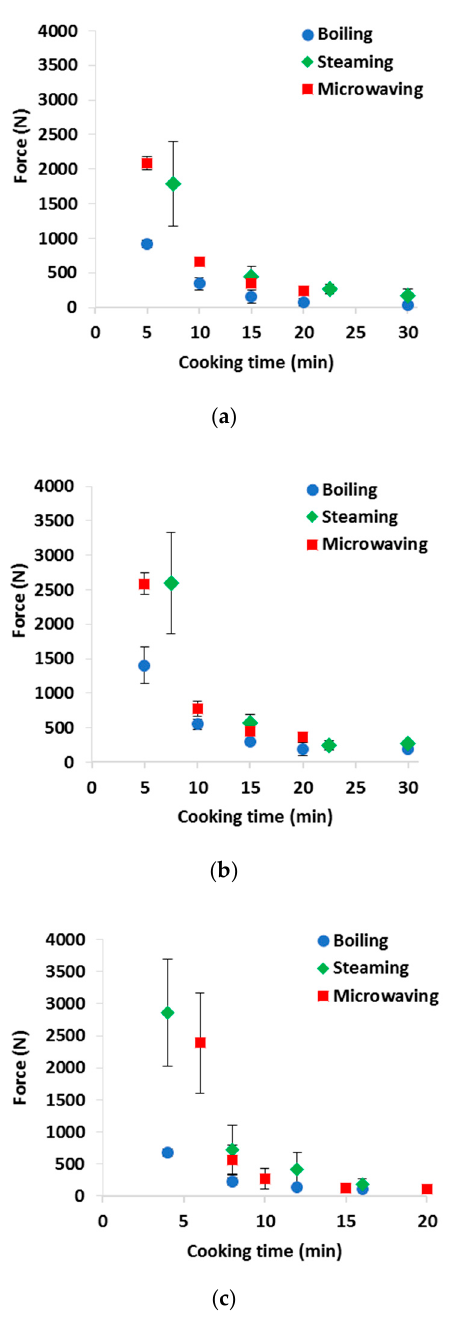
Figure 1. Texture evaluation of ( a ) cauliflowers, ( b ) carrots and ( c ) sweet potatoes cooked by different cooking systems and times. Data are averaged per trial and standard deviation bars are shown.